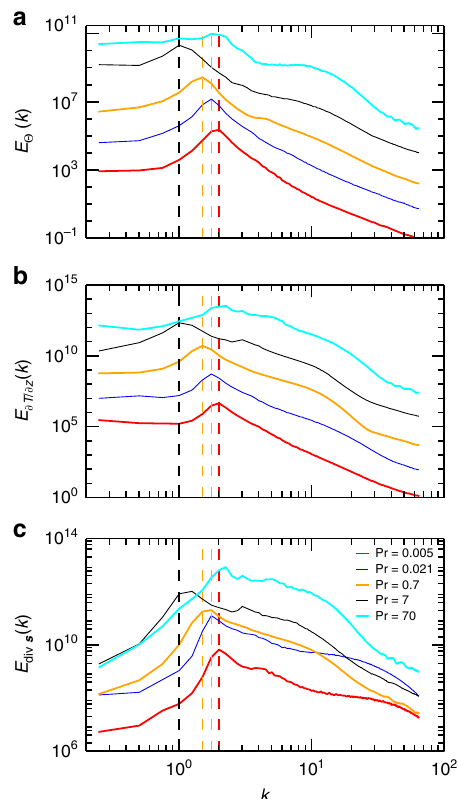
Fig. 9 Scale correlations of bulk and boundary layer. Time-averaged spectra of temperature Θ in the midplane ( a ), of vertical temperature derivative ∂ T / ∂ z at the bottom and top plates ( b ), and of skin friction fi eld divergence at the bottom and top plates ( c ) are compared for fi ve different Prandtl numbers. The vertical dashed lines denote the maximum wavenumbers k (cid:4) Θ and are replotted in b and c . The dashed lines for Pr = 0.021 and 70 (blue and cyan) collapse. Spectra are shifted vertically for better